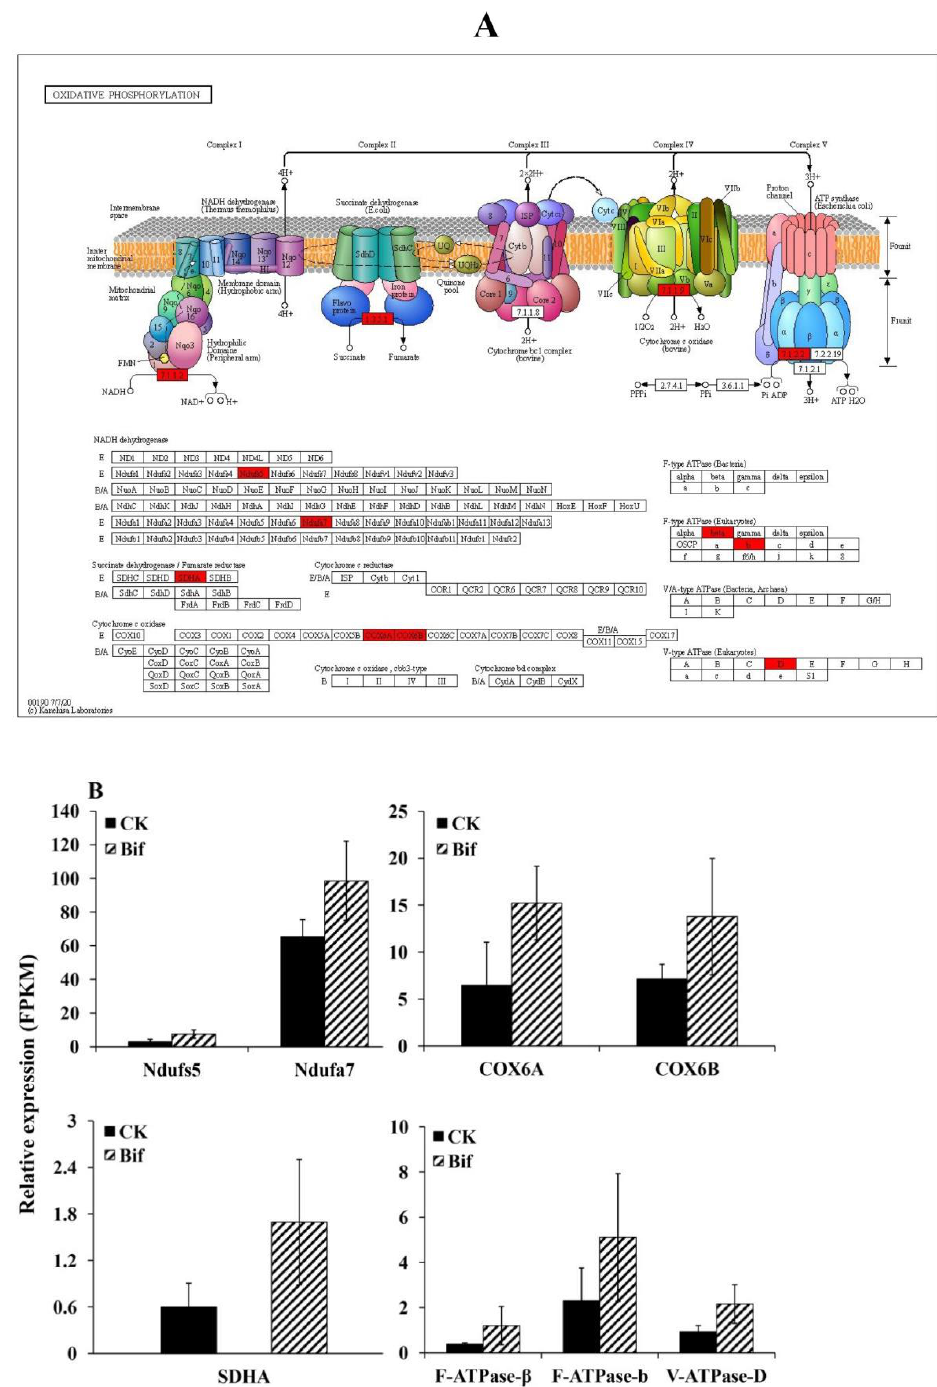
Figure 8. ( A ) The KEGG pathway of the oxidative phosphorylation pathway responds to bifenazate treatment in Plutella xylostella , and genes highlighted in green are enriched and down-regulated. ( B ) The expression levels (FPKM value) of eight mitochondrial genes in P. xylostella that treated with bifenazate at concentrations of LC 30 .